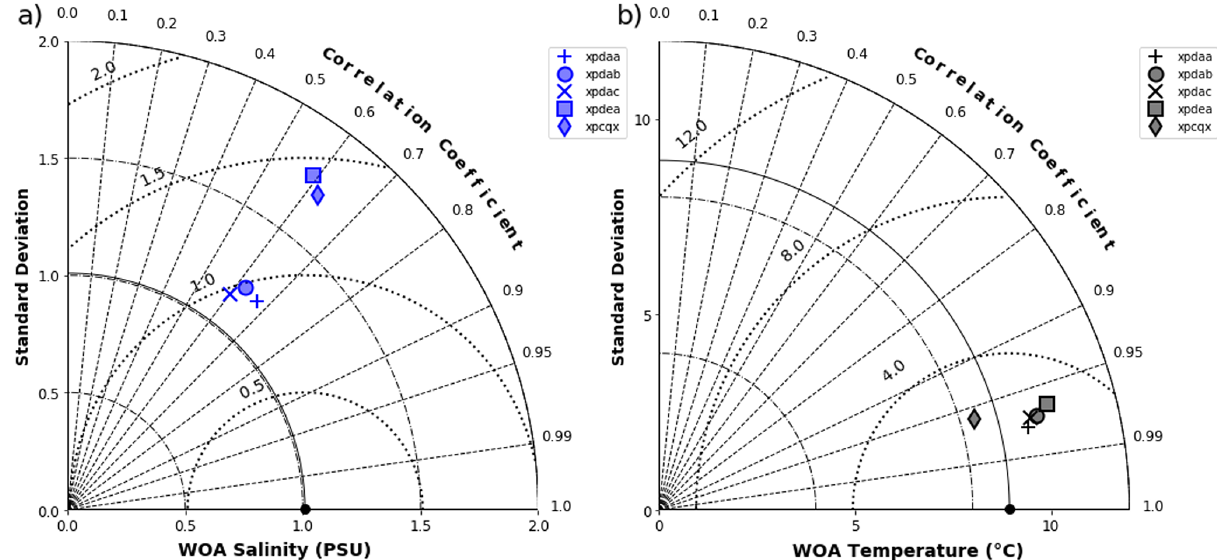
Figure 1. Taylor diagrams summarising the performance of the four control candidate simulations (XPDAA, XPDAB, XPDAC, XPDEA) in terms of their correlation, centred root-mean-square error, and ratio of variance to the NOAA World Ocean Atlas (a) salinity and (b) temperature databases (Zweng et al., 2019). The simulations were selected from a large FAMOUS pre-industrial perturbed parameter ensem- ble following the circulation performance screening described in Sect. 2.2. XPCQX represents the initial experiment, upon which the four control candidates aim to improve.